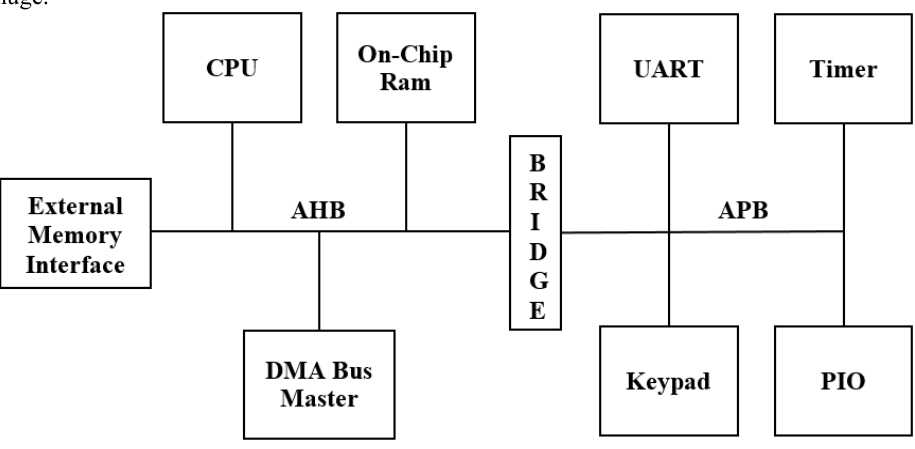
Fig. 1. AMBA based microcontroller